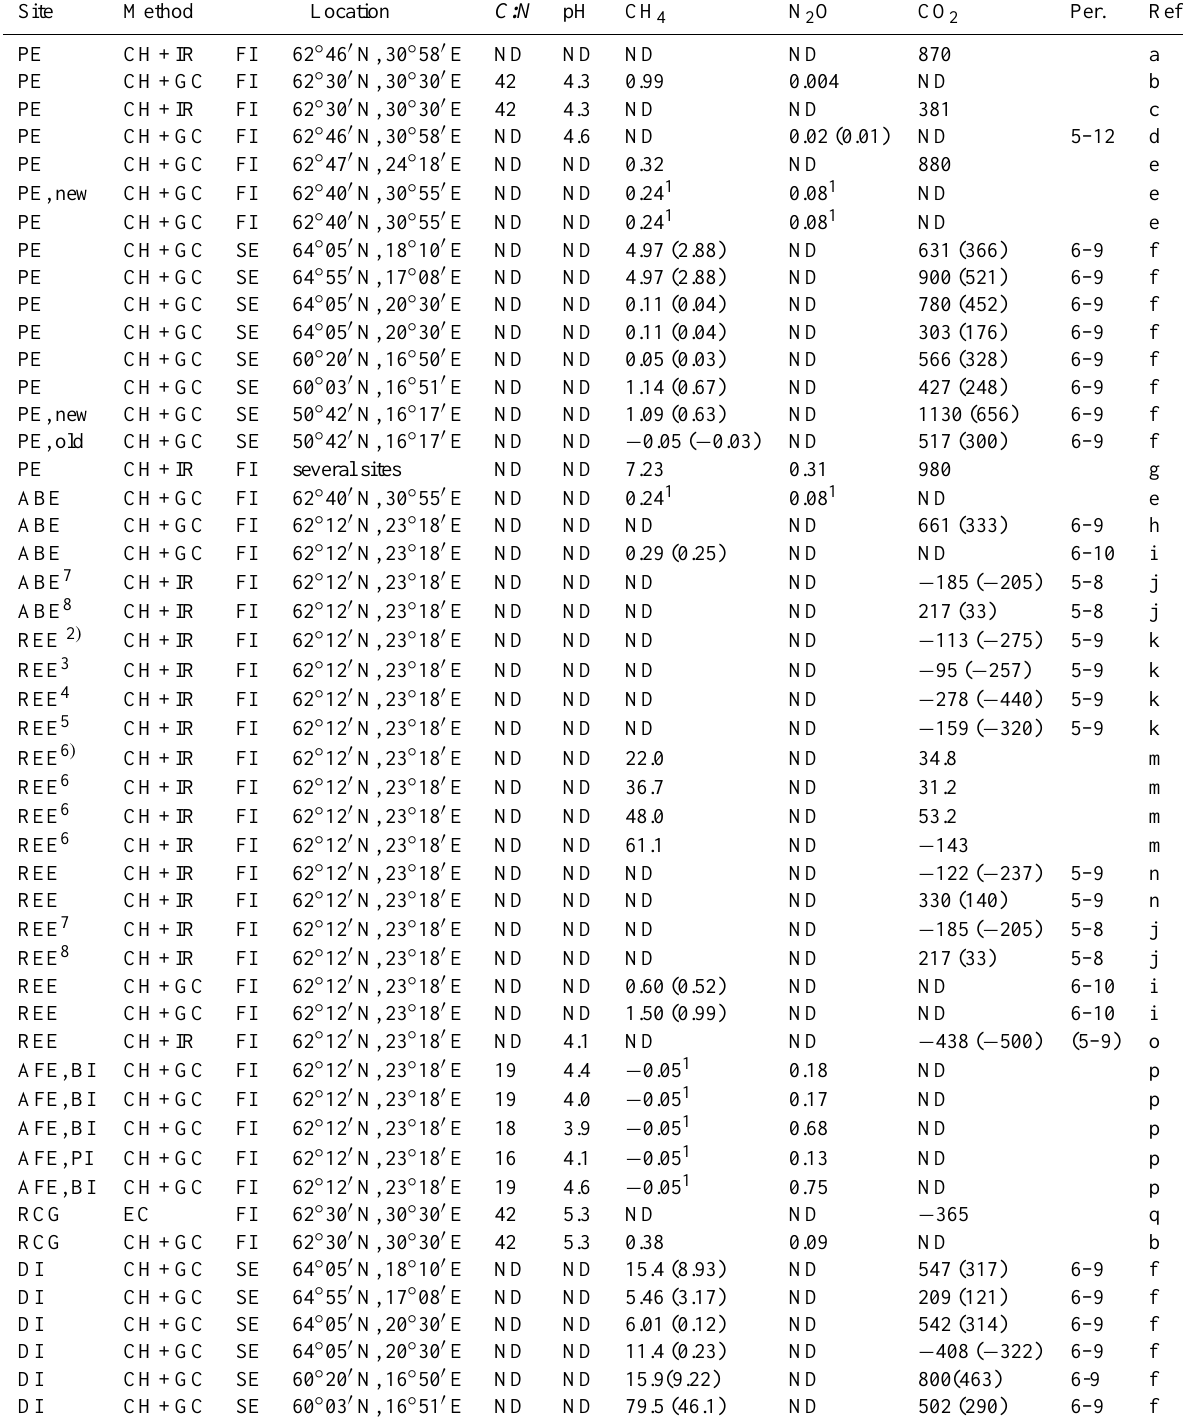
Table 4. Annual balances of CH 4 (gm − 2 yr − 1 ), N 2 O (gm − 2 yr − 1 ) and net ecosystem CO 2 exchange (gm − 2 yr − 1 ) from peat extraction sites (PE=active site, ABE=abandoned, AFE=afforested with pine – PI – or birch – BI, REE=restored, RCG = abandoned extraction site cultivated with reed canary grass) in Finland (FI) and Sweden (SE). Also, emissions from the ditches (DI) are shown. A negative value indicates uptake, a positive value indicates emission. Methods used for the measurements are CH+GC=chamber method+analysis by gas chromatograph, IF+GC= inverted funnel for gas collection from ditches, CH+IR=chamber method+infra-red analyzer and EC=Eddy covariance method. If annual emission is estimated based on seasonal results the original measuring period (months from-to) is shown in column “Per.” and the original emission value for that period in